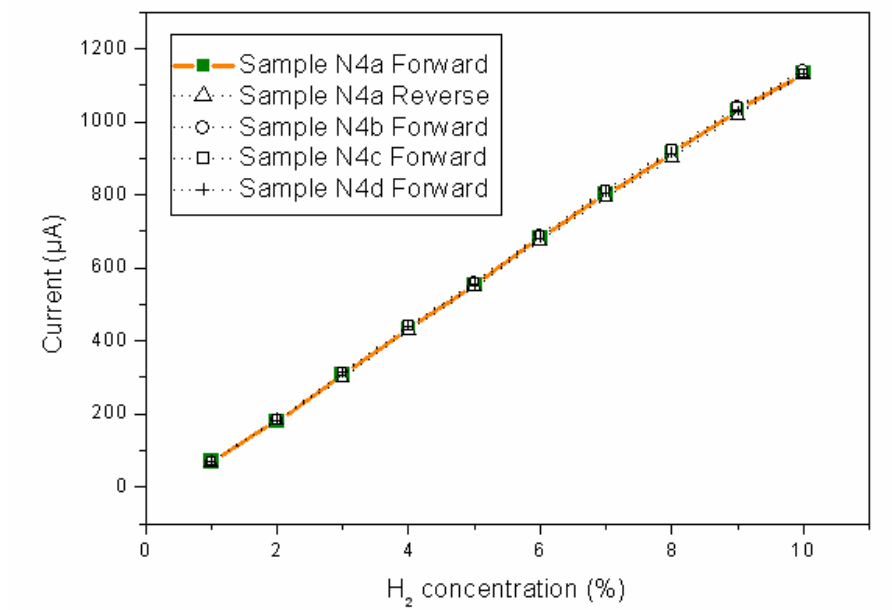
Figure 7. Linear relation for 0.04 M NaBH (sample N4) concentration over a wide range of hydrogen 4 concentration (1-10%) and a sensing area of 2 cm 2 . The dotted lines are results from calibrations with different